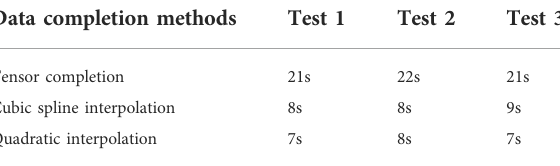
TABLE 4 Comparison of data completion methods in the ef fi ciency.